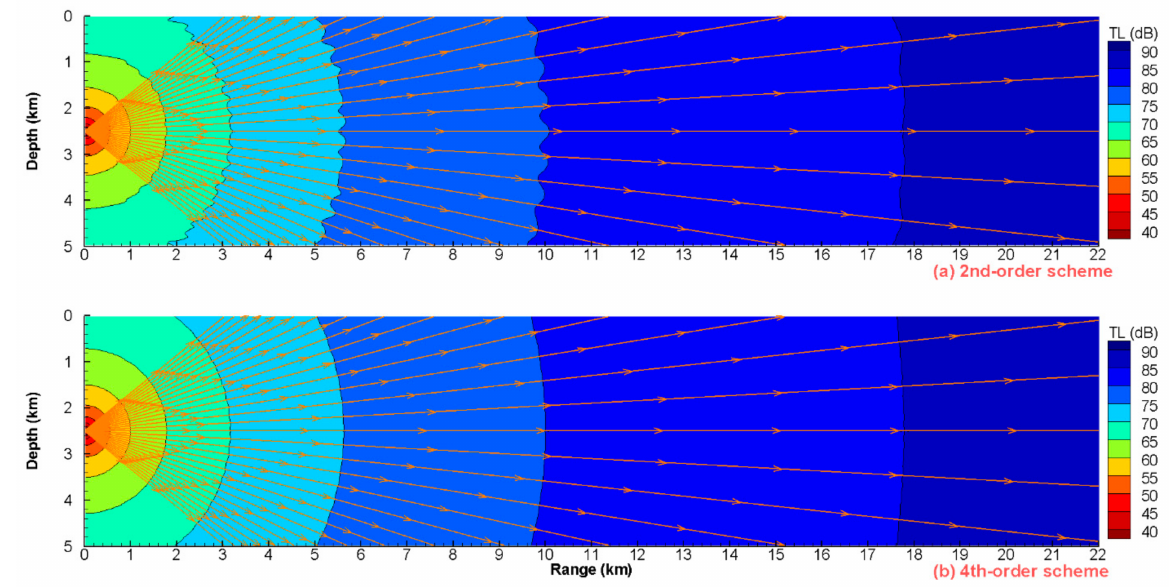
Figure 5. TL contours and TASI streamlines obtained from the VWI model ( h = 20 m) for the free acoustic field using the 2nd-order FD scheme and the 4th-order FD